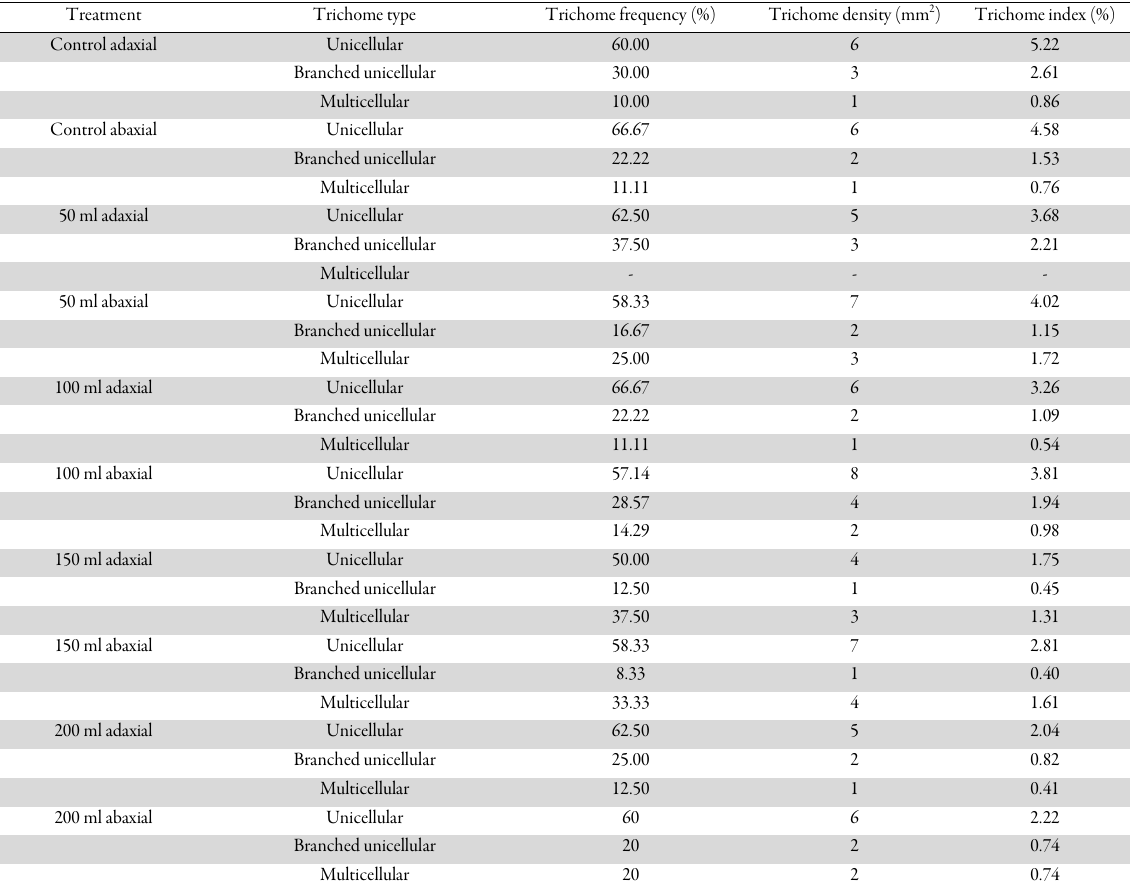
Fig. 2. Trichome types observed in the study; a- simple unicellular trichome; b- branched unicellular trichome; c- multicellular trichome X400 Table 9. Trichome parameters of A. esculentus ‘Clemson’ spineless variety, as affected by different concentrations of spent oil pollution